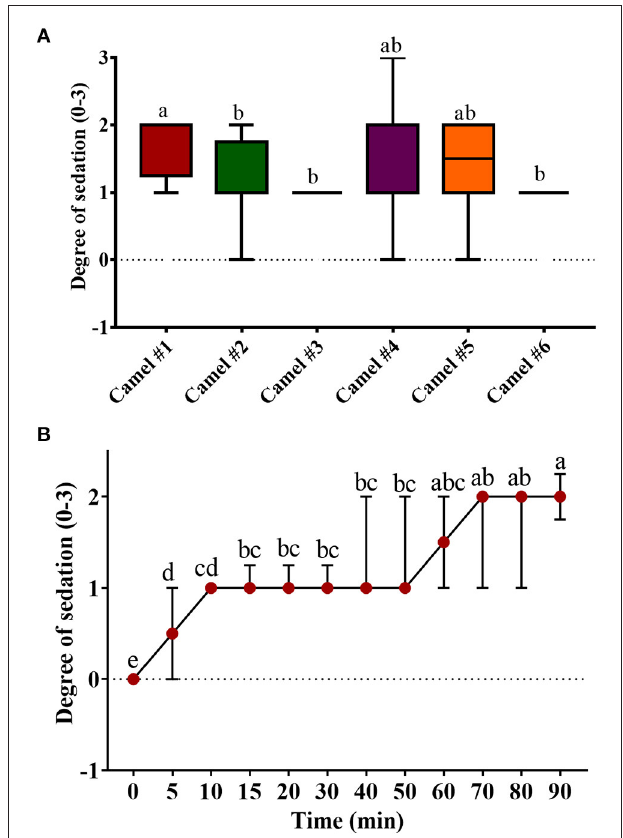
FIGURE 2 | The sedation score in camels after injection of acepromazine (0.1 mg/kg i.v.). (A) Boxplot showing sedation scores with all data points represented. (B) The progression of acepromazine sedation in camels. Each data point represents the average of two recordings from two experts for all camels. Median values in each plot followed by a different lowercase letter (a, b, c) are significantly different by the Duncan test at p ≤ 0.05.